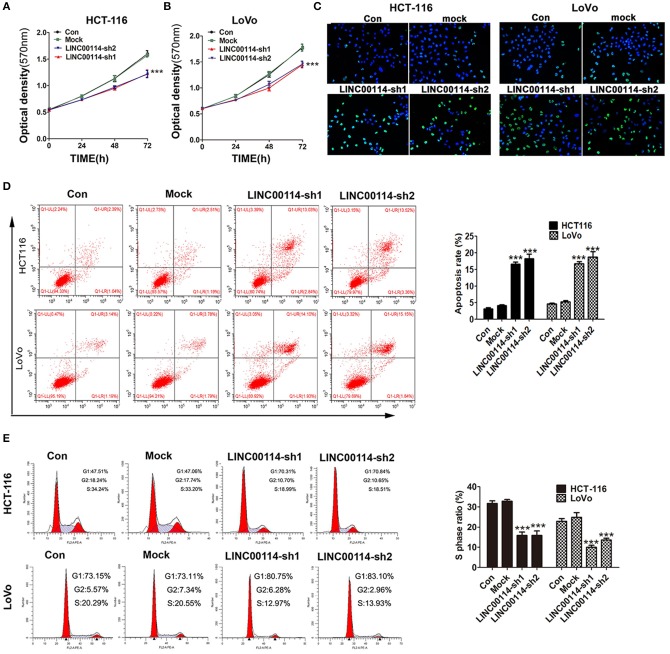
LINC00114 interference facilitates apoptosis and represses cell cycle progression in vitro. (A–C) sh-LINC00114 inhibits cells proliferation. (D) Apoptosis of CRC cells transfected with the sh-LINC00114 or the control plasmid for 48 h, analyzed by flow cytometry. (E) Cell cycle analysis of HCT116 and LoVo cells transfected with the LINC00114 or the control plasmid for 48 h using flow cytometry. ***P < 0.001. Con, the group only treated with PBS; Mock, the cells transfected with the empty vector plasmid.